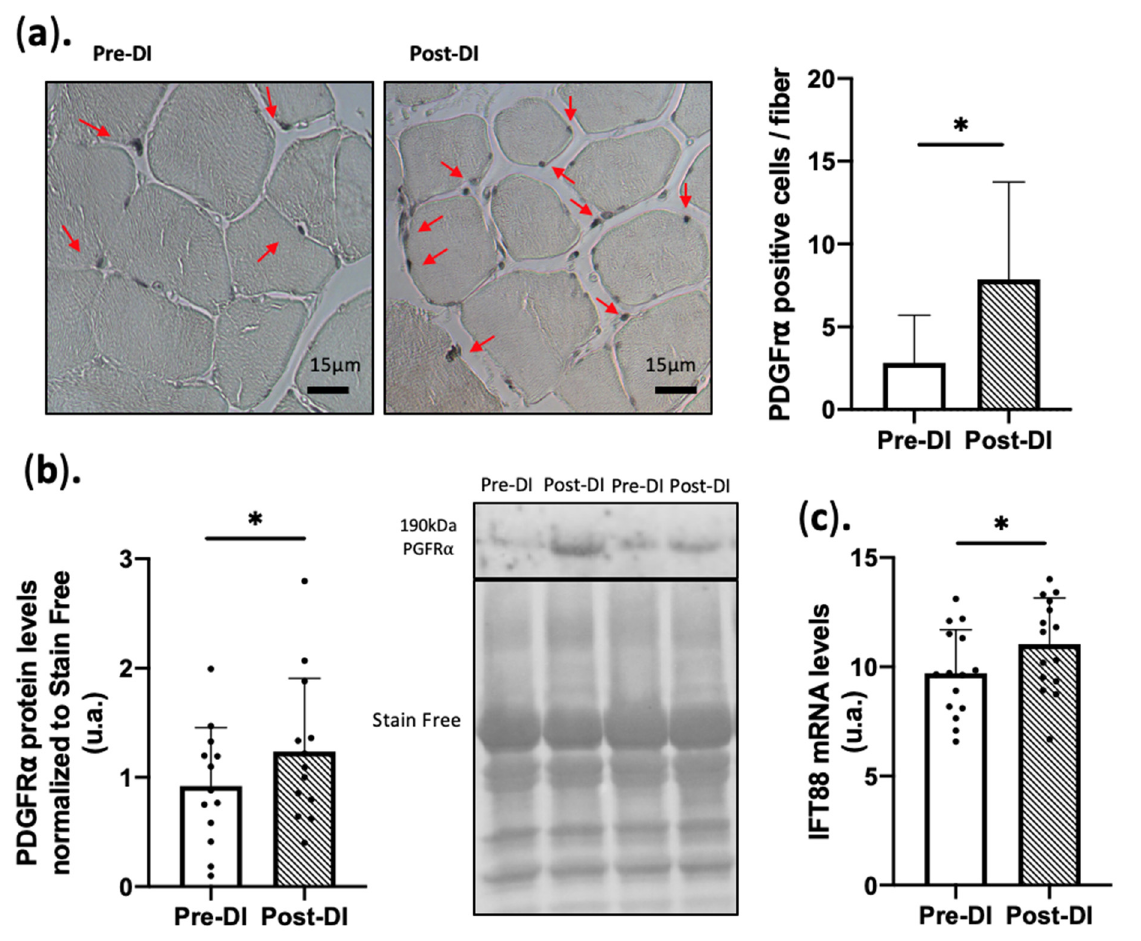
Figure 4. Expression of cell surface marker PDGFR α in VL biopsies before (Pre-DI) and after (Post-DI) 5 days of DI. ( a ) Representative images of Pre-DI and Post-DI vastus lateralis muscle sections stained with an anti-PDGFR α antibody; arrows show the staining localization. Bar plots represent relative PDGFR α signal following staining of paraffin-embedded transversal vastus lateralis sections from Pre-DI and Post-DI muscle biopsies. ( b ) PDGFR α protein level in Pre-DI and Post-DI muscle biopsies, data were normalized to the total protein staining using Stain-free technology. n = 13/time point ( c ) IFT88 gene expression levels in Pre-DI and Post-DI muscle biopsies. n = 15/time point; * p <0.05, Paired t -test or Wilcoxon matched-pairs signed-rank test was performed according to normality.